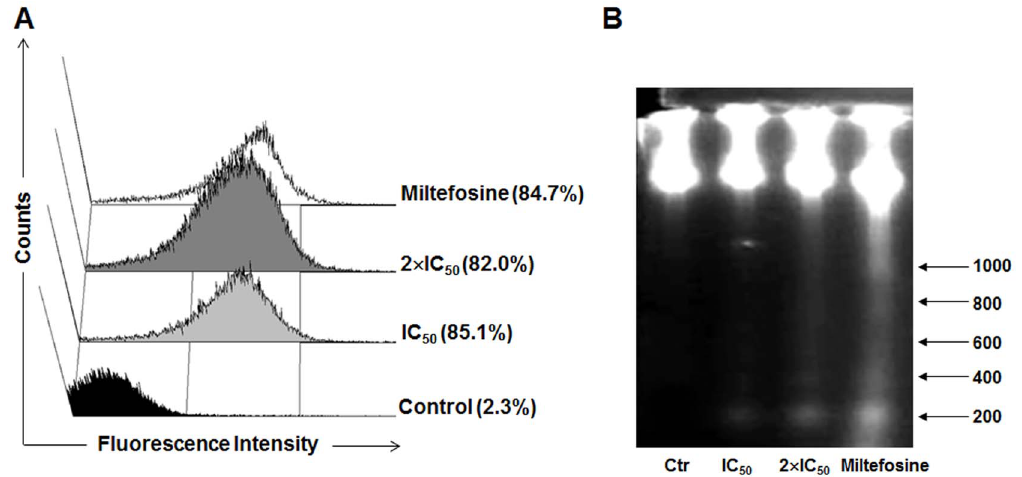
Figure 6. Analysis of DNA fragmentation in MDL28170-treated Leishmaniaamazonensis promastigotes. Cells were incubated or not (Control, Ctr) with IC 50 or two times the IC 50 (2 6 IC 50 ) doses of MDL28170 for 72 h. In the analysis of TUNEL positivity (A), cells were fixed, stained with PI and dUTP-FITC in the presence of terminal deoxynucleotidyl transferase and RNase enzyme and analyzed by flow cytometry. The DNA profiles of total genomic DNA by 1.2% agarose gel electrophoresis (85 V for 2 h) are shown in B. DNA from promastigotes treated with 40 m M miltefosine for 24 h were used as a positive control of oligonucleossomal fragmentation. The DNA fragments sizes, based on 100 bp DNA ladder migration, are expressed in